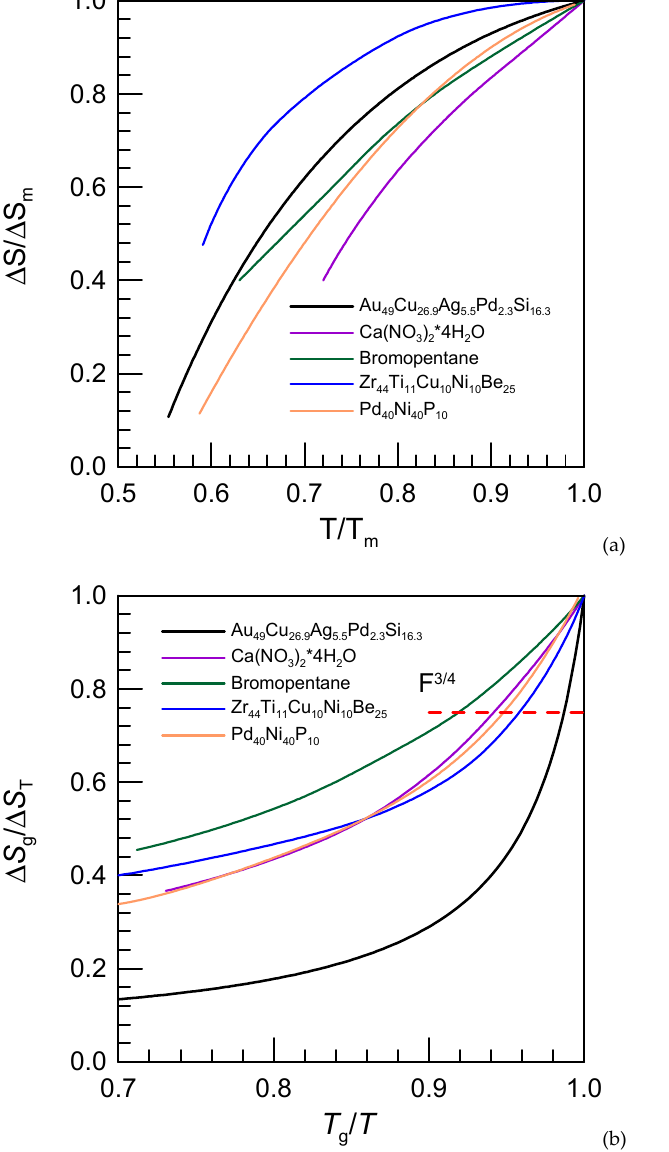
Figure 6. Δ S ( T )/ Δ S ( T m ) as a function of T / T m ( a ) and Δ S ( T g )/ Δ S ( T ) as a function of T g / T ( b ) for different Figure 6. ∆ S ( T )/ ∆ S ( T m ) as a function of T / T m ( a ) and ∆ S ( T g )/ ∆ S ( T ) as a function of T g / T ( b ) for materials, as indicated. different materials, as The excess entropy in metallic glasses is dominated by the configurational entropy while the excess vibrational entropy was found to be very small [124]. To the contrary molecular and network glasses indicate vibrational contribution to the excess liquid/glass entropy [125].